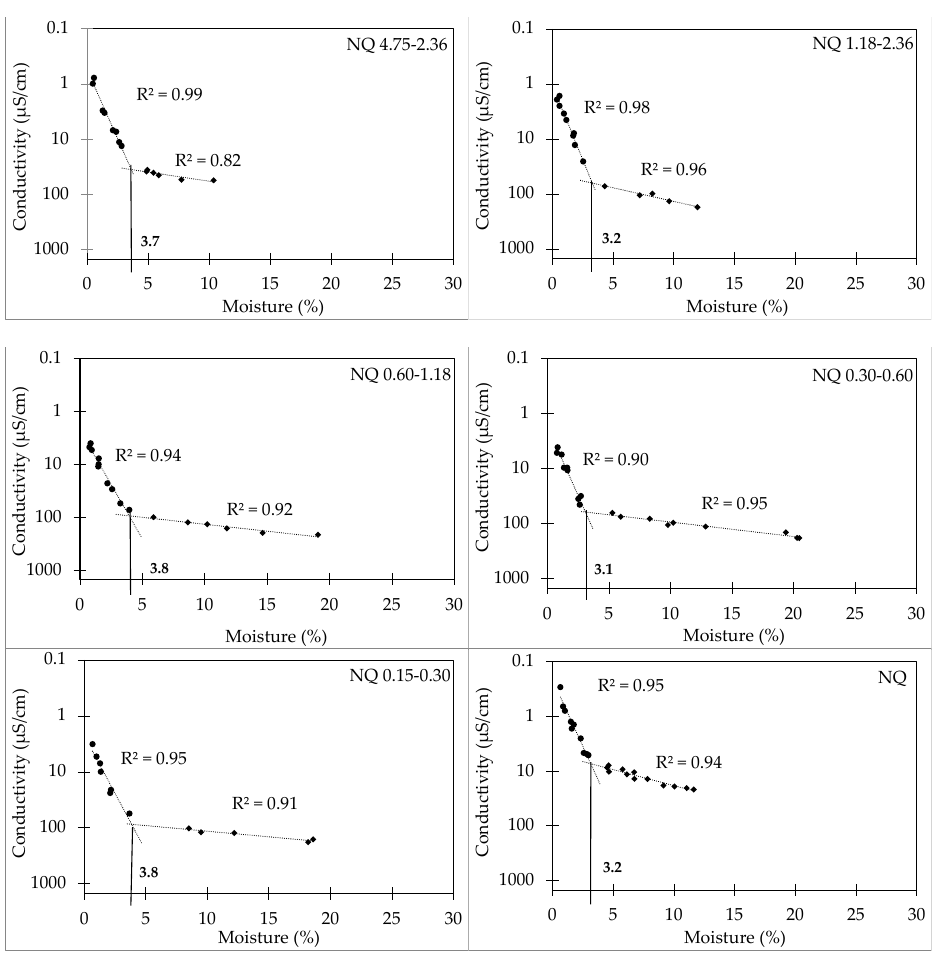
Figure 3. Moisture contents versus conductivity plots, including the SSD state of NQ samples.